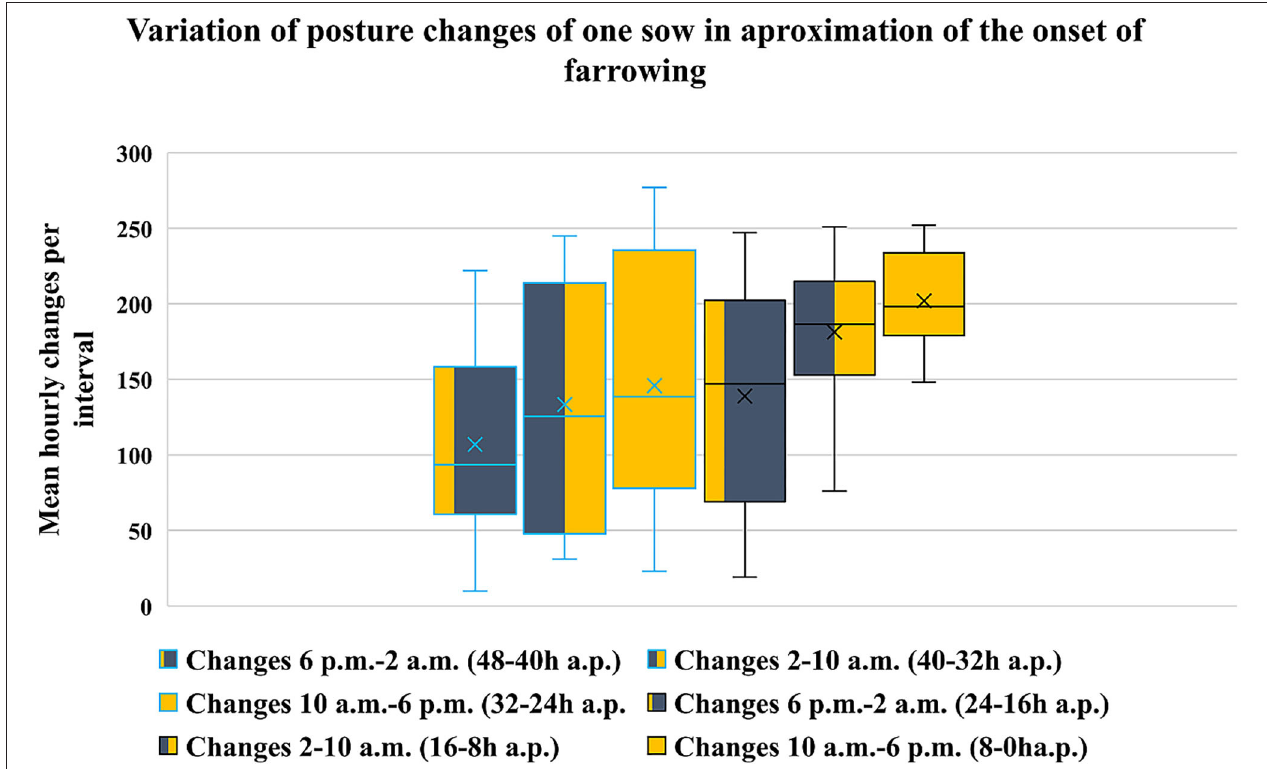
FIGURE 7 | Variation of the mean hourly behavior/posture changes per 8-h interval with diverging time until farrowing. Blue bordered 48–24h before farrowing and black bordered 24–0h before farrowing. One frame per second was analyzed.